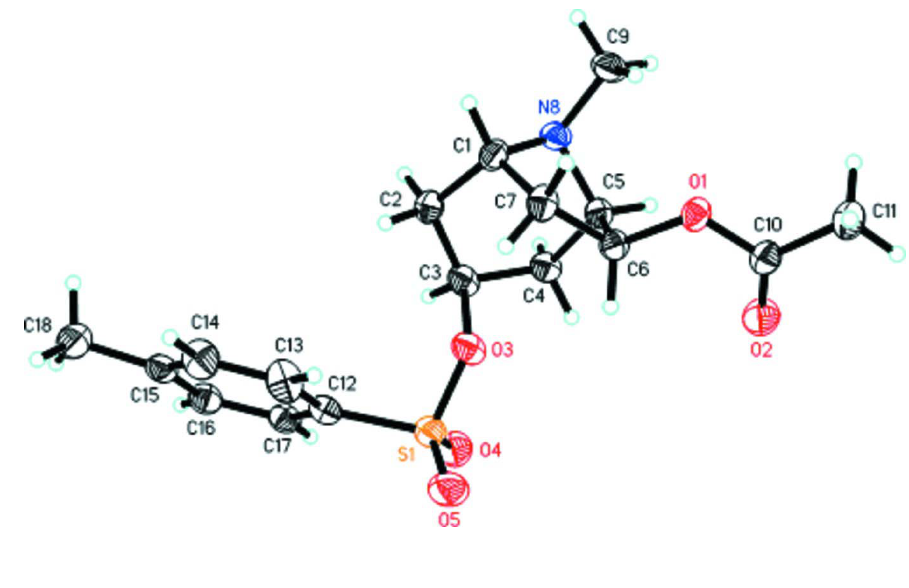
Figure 1 Ellipsoid